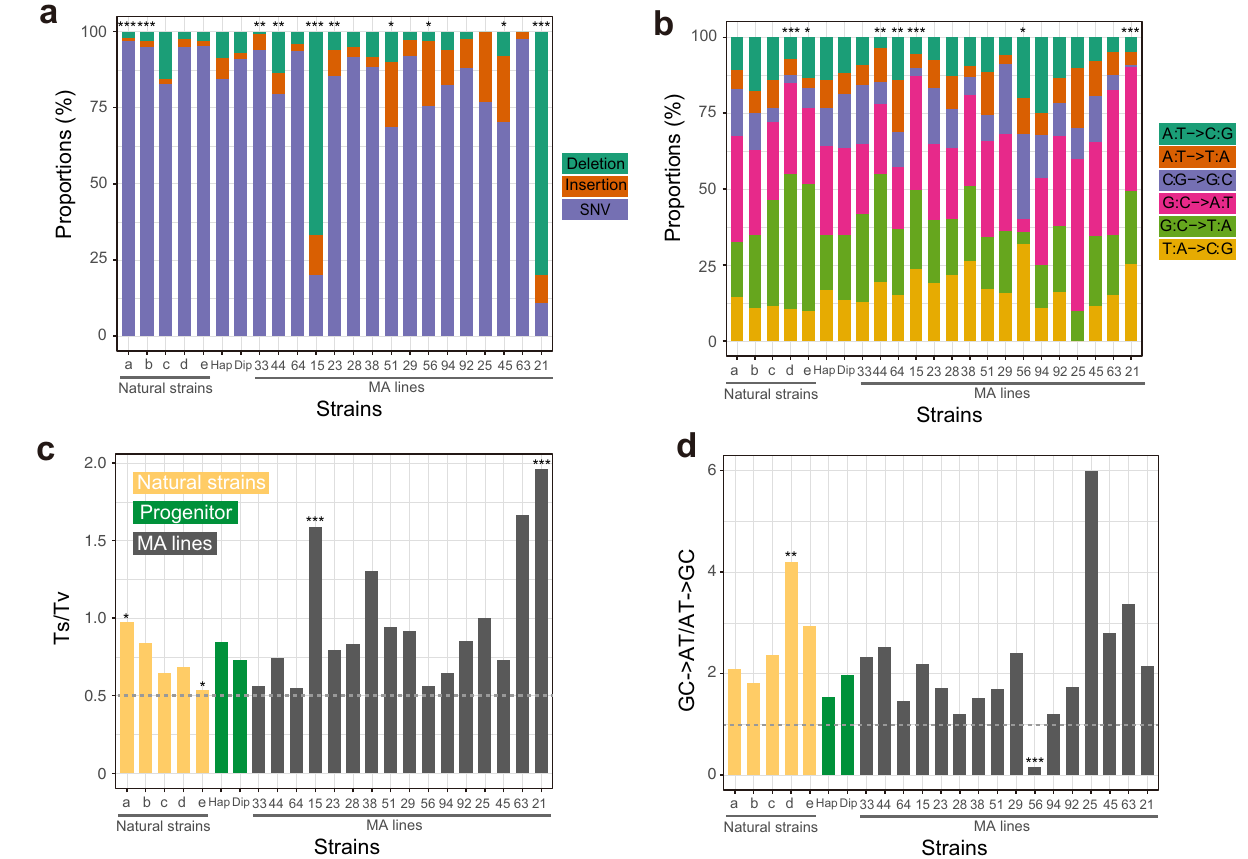
Fig. 4 Molecular spectra of mutations in 16 MA lines and 5 natural yeast strains estimated by MA + WGS. a Proportions of SNVs, insertions, and deletions among all mutations. b Relative proportions of the six types of SNVs. c Number of transition mutations relative to the number of transversion mutations (Ts/Tv). d Number of GC → AT mutations relative to the number of AT → GC mutations. In c and d , the gray dotted line shows the random expectation. In all panels, the small letters on the X -axis refer to natural strains (a DBY4974/DBY4975; b SEY6211; c SK1/BY; d DBVPG6765; and e YPS128/DBVPG6765), “ Hap ” refers to the progenitor in the haploid form, “ Dip ” refers to the progenitor in the diploid form, and the numbers refer to IDs of MA lines. Two-tailed chi-squared test is performed between each strain and the progenitor: * , P < 0.05; ** , P < 0.01; *** , P <